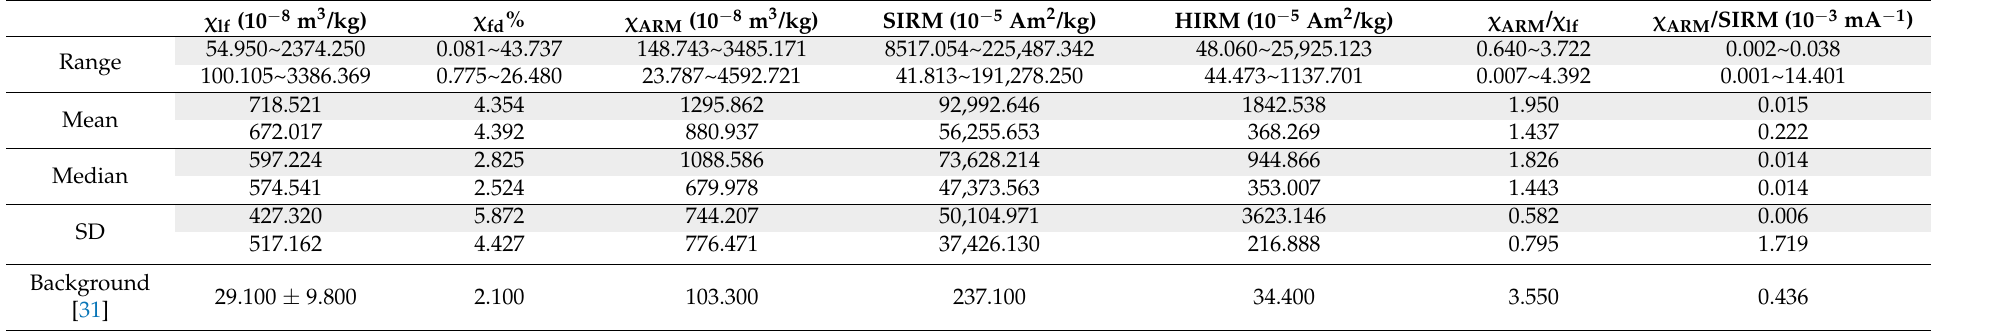
Table 1. Magnetic measurement results of samples before and after COVID-19